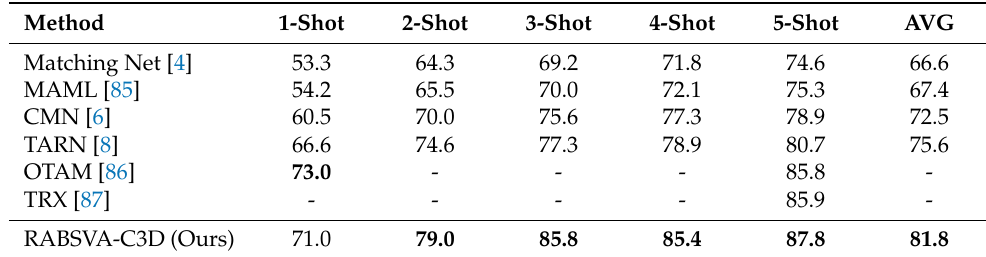
Table 3. The top-1 accuracies of C3D embedding our RABSVA module compared with state-of-the-art methods for 1-shot to 5-shot, the average of which is listed in